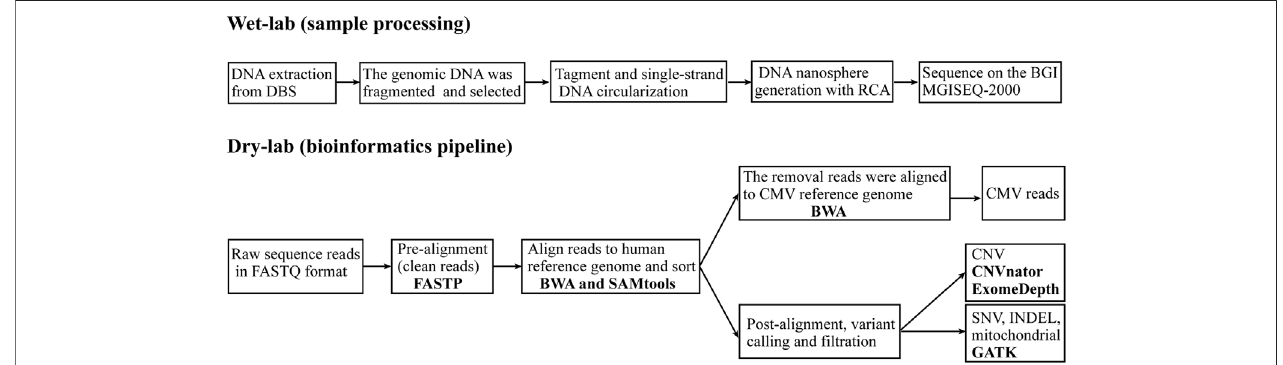
FIGURE1 | Overview of thewhole genome sequencing and analytics pipeline. The WGS pipeline includes two sections: wet-lab (sample processing), which starts with DNA extraction from dried blood spots (DBS) and continues to generate a whole genome library that is sequenced on an MGISEQ-2000 sequencer; and dry-lab (bioinformatics pipeline), which starts with raw sequence reads in FASTQ format and continues with analysis using a series of software tools to identify genetic variants and reads from CMV. RCA, rolling circle ampli fi cation; BWA, Burrows-Wheeler Aligner; GATK, Genome Analysis Toolkit; CNV, copy number variant; SNV, single nucleotide variant; INDEL, small insertions and deletion; CMV,